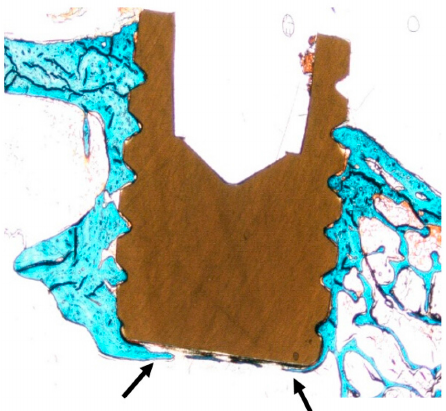
Figure 6. Histologic section of nHA-coated PEEK screw implanted into the rabbit tibia for 12 weeks. The threads are filled with bone tissues, showing osteoconductive feature of nHA-coated PEEK (arrow). Reprinted from [104] with permission of MDPI under the terms and conditions of the Creative Commons Attribution license.